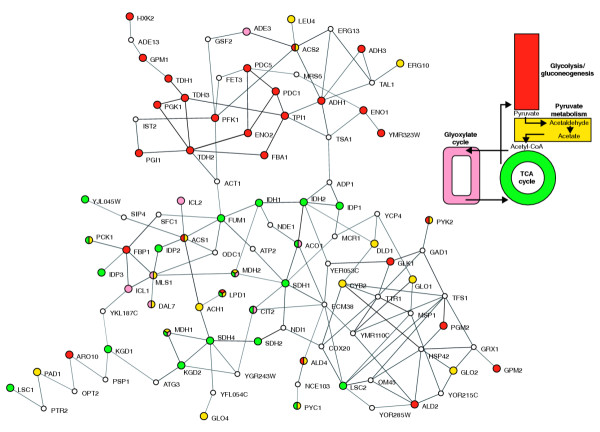
Largest connected subgraph resulting from combined query on four pathways involved in carbohydrate metabolism: glycolysis/gluconeogenesis (red); pyruvate metabolism (yellow); TCA cycle (green); and the glyoxylate cycle (pink). Genes encoding proteins involved in more than one pathway are highlighted with multiple colors. Uncolored vertices represent non-pathway genes that were recovered in the combined pathway query. See text for further details.